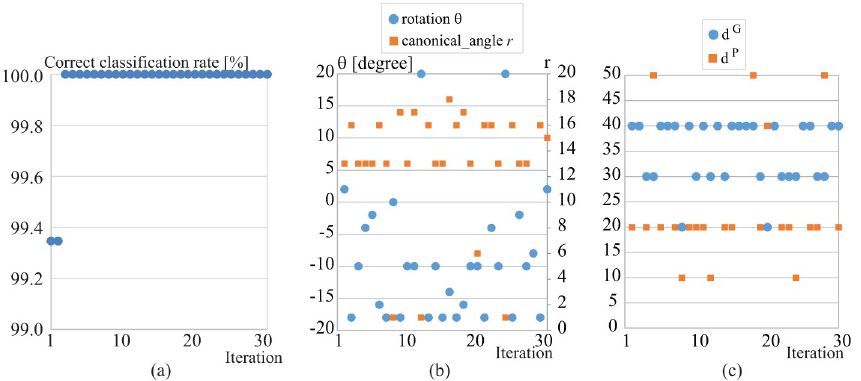
Fig 14. (a) Correct classification rate (CCR) at each iteration by applying the boosting method to similarities of all parameters (rotation angles, canonical angles, and dimensionalities), (b) selected canonical angle r and rotation angle θ , and (c) selected d G and d P